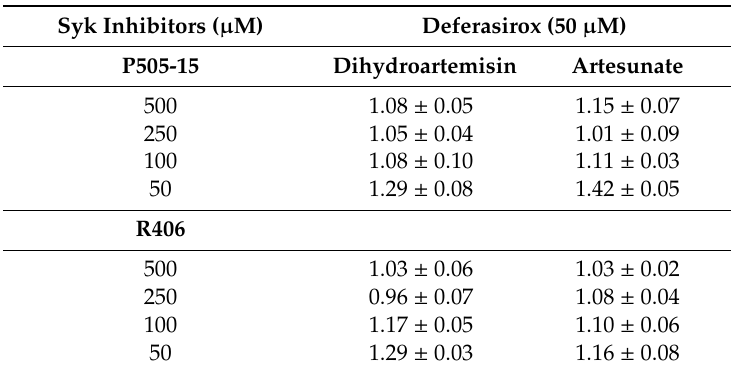
Table 2. Combination index value (CI) 24 h after treatment. Combination index (CI) (Chow–Talalay) of di ff erent SYK inhibitors (P505-15 and R406) at di ff erent concentrations (50–500 nM) in combination with di ff erent artemisinin derivatives (dihydroartemisinin and artesunate) using a fixed concentration of the iron chelator Deferasirox (DFX) after 24 and 48 h of